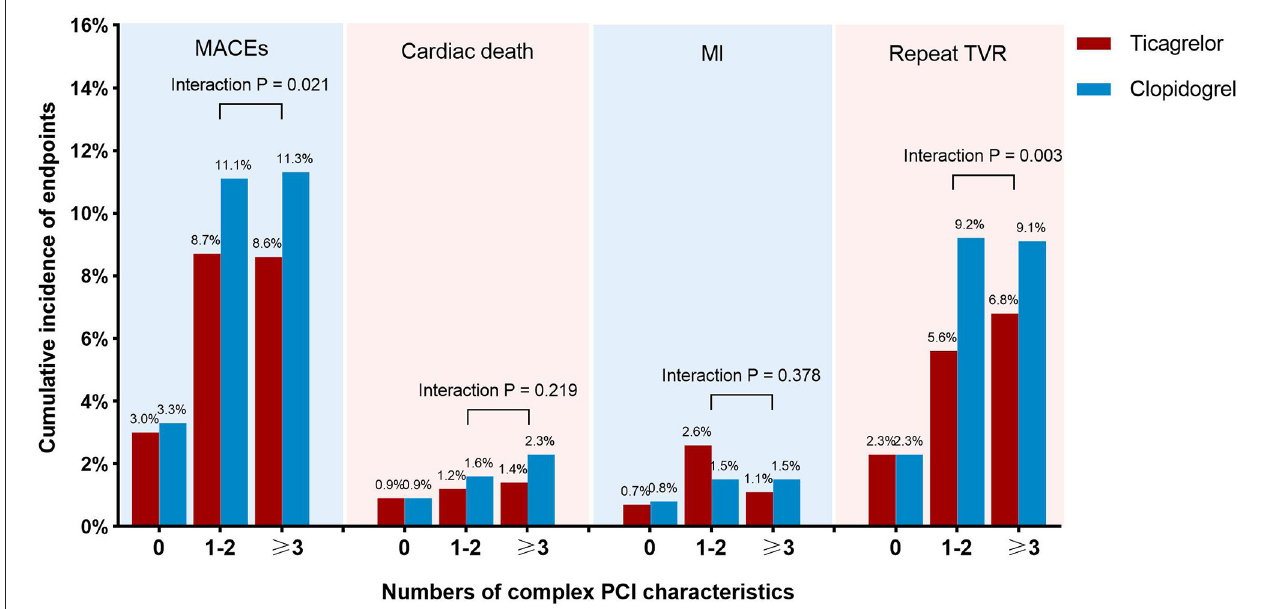
FIGURE 3 | Incidence of clinical outcomes at 1 year of patients treated with ticagrelor vs. clopidogrel stratified by number of complex PCI characteristics. The incidences of endpoints, including major adverse cardiac events, cardiac death, myocardial infarction, and repeat target vessel revascularization, were compared between patients treated with ticagrelor and clopidogrel among subgroups of patients with 0, 1–2, or 3 or more complex PCI